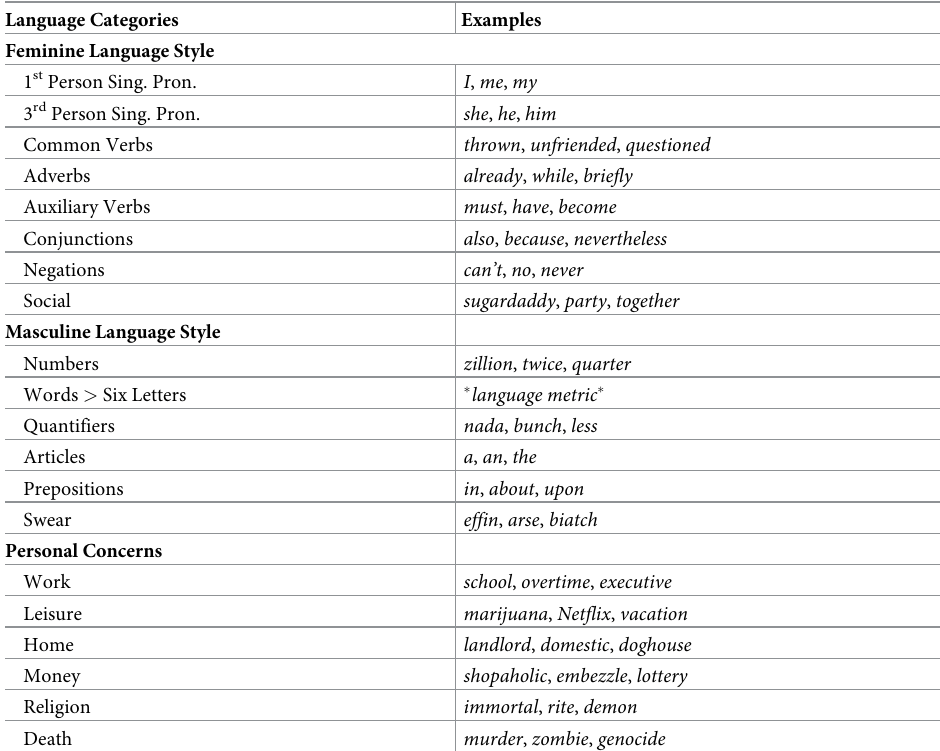
Table 1. Examples of LIWC 2015 language categories for statistical